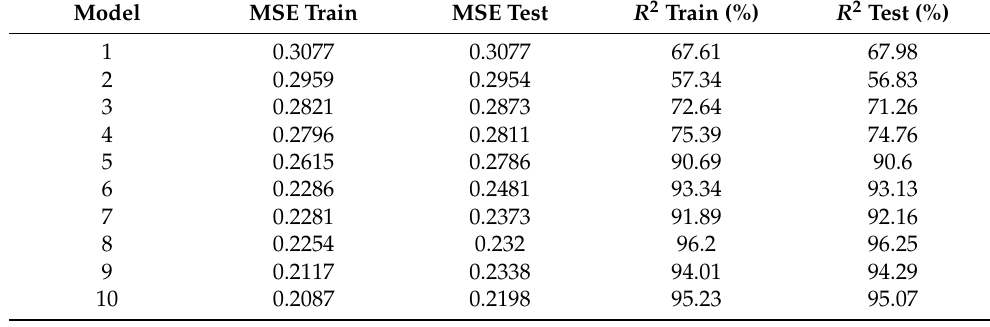
Table 4. Effect of model complexity on R_Squared and MSE.